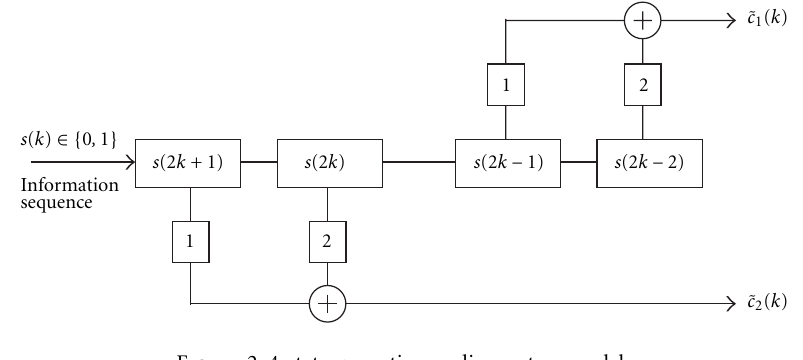
Figure 2: 4-state space-time coding system model.